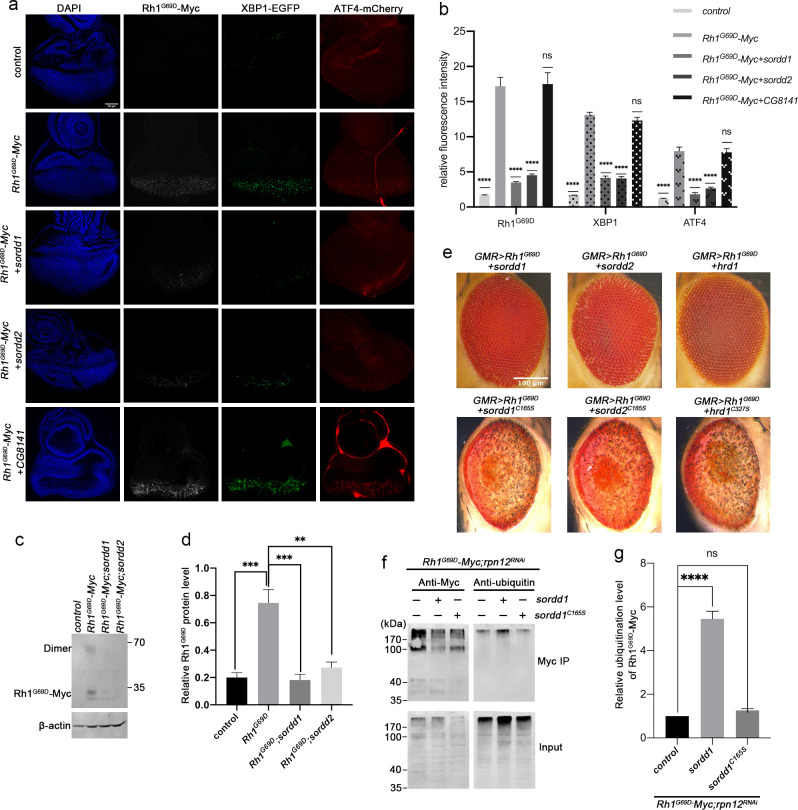
The E3 ubiquitin ligases SORDD1/2 reduce the UPR by promoting the degradation of Rh1G69D.(a) Fluorescence images of eye imaginal discs. The ER stress markers, Xbp1-EGFP and ATF4-mCherry (control, GMR-gla4 UAS-Xbp1 ATF4-mCherry/+), were induced by the expression of Rh1G69D–Myc (Rh1G69D–Myc, GMR-gal4 UAS-Xbp1 ATF4-mCherry UAS-Rh1G69D–Myc/+). Expressing SORDD1 (Rh1G69D–Myc+sordd1, GMR-gla4 UAS-Xbp1 ATF4-mCherry UAS-Rh1G69D–Myc/+;UAS-sordd1/+) or SORDD2 (Rh1G69D–Myc+sordd2, GMR-gla4 UAS-Xbp1 ATF4-mCherry UAS-Rh1G69D–Myc/+;UAS-sordd2/+) reduced Rh1G69D–Myc levels as well as Xbp1-EGFP and ATF4-mCherry signals. In contrast, expressing CG8141 (Rh1G69D–Myc+CG8141, GMR-gla4 UAS-Xbp1 ATF4-mCherry UAS-Rh1G69D–Myc/+;UAS-CG8141/+) did not affect levels of Rh1G69D–Myc, Xbp1-EGFP, or ATF4-mCherry. The Rh1G69D–Myc epitope is labeled white; spliced Xbp1-GFP is labeled green; mCherry under control of the ATF4 promoter/5’ UTR is labeled red. Scale bar, 50 μm. (b) Quantification of relative fluorescence from a; error bars indicate SEM (n = 4); ns, not significant; ****p<0.0001 (one-way ANOVA, Sidak's multiple comparisons test). (c) Western blot analysis shows the level of Rh1G69D–Myc is reduced by expressing SORDD1 and SORDD2 in pupa eyes. Note Rh1G69D can form a dimer. (d) Quantification of b, error bars indicate SEM; n = 3, **p<0.01, ***p<0.001 (one-way ANOVA, Sidak's multiple comparisons test). (e) E3 ubiquitin ligase activity of SORDD1, SORDD2 and HRD1 is essential for suppression of Rh1G69D induced cell degeneration. SORDD1 (sordd1C165S), SORDD2 (sordd2C165S) and HRD1 (hrd1C327S) are inactivated by mutating the conserved Cys on the active site of the RING domain to Ser. Scale bar, 100 μm. (f) Ubiquitination of Rh1G69D by SORDD1 in vivo. Head lysate of Rh1G69D–Myc (GMR-gla4 UAS-Rh1G69D–Myc/rpn12RNAi) flies co-expressing SORDD1 (GMR-gla4 UAS-Rh1G69D–Myc/rpn12RNAi;UAS-sordd1/+) or SORDD1C165S (GMR-gla4 UAS-Rh1G69D–Myc/rpn12RNAi;UAS-sordd1C165S/+) were immunoprecipitated with anti-Myc antibody, and stained against Myc (left) or ubiquitin (right). The proteasomal degradation of Rh1G69D was inhibited by knocking down the proteasome component Rpn12 (rpn12RNAi) [54]. (g) Quantification of relative ubiquitination levels of Rh1G69D–Myc from f, error bars indicate SEM; n = 3, ns, not significant, ****p<0.0001 (one-way ANOVA, Sidak's multiple comparisons test).